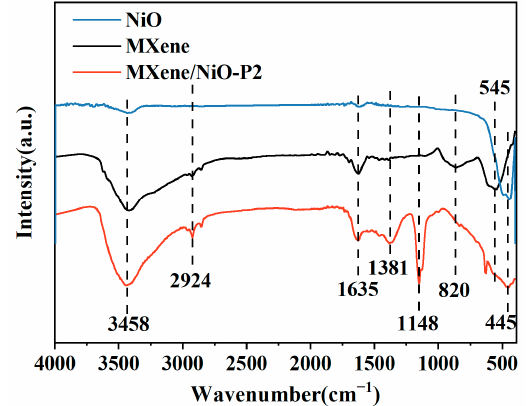
Figure 4. FTIR spectra of MXene, NiO, and MXene/NiO-P2.